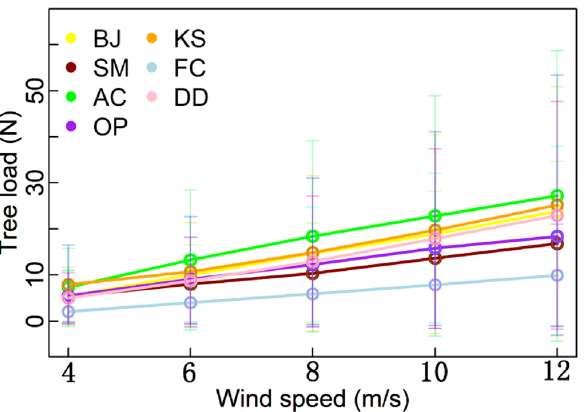
Figure 3. Wind load of different wind speed in 7 species. BJ, SM, AC, OP, KS, FC, and DD are the abbreviations of Bischofia javanica , Schefflera macrostachya , Acacia confuse , Ormosia pinnata , Ficus concinna , Khaya